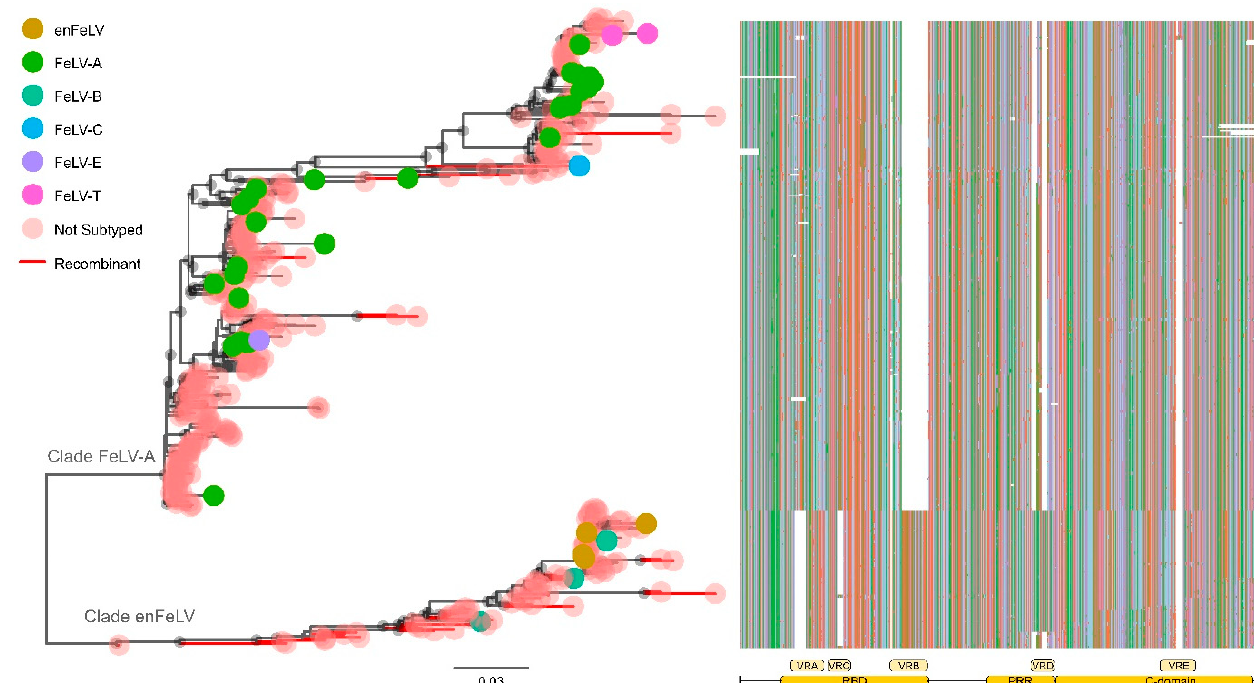
Figure 3. Maximum likelihood tree of 404 FeLV SU env sequences and alignment. Branches colored in red represent recombinant sequences detected by RDP4 software. Colored circles at the tip of the branches represent sequences with a previously defined subgroup based on interference assays. Red circles denote sequences without information on subgroup assignment: yellow: enFeLV; green: FeLV-A; blue: FeLV-A; aquamarine: FeLV-B; blue: FeLV-C; purple FeLV-E; pink: FeLV-T. RBD: receptor binding site, PRR: proline-rich region, VRA, VRC, VRB, VRD, VRE: variable region A, C, B, D and E respectively.